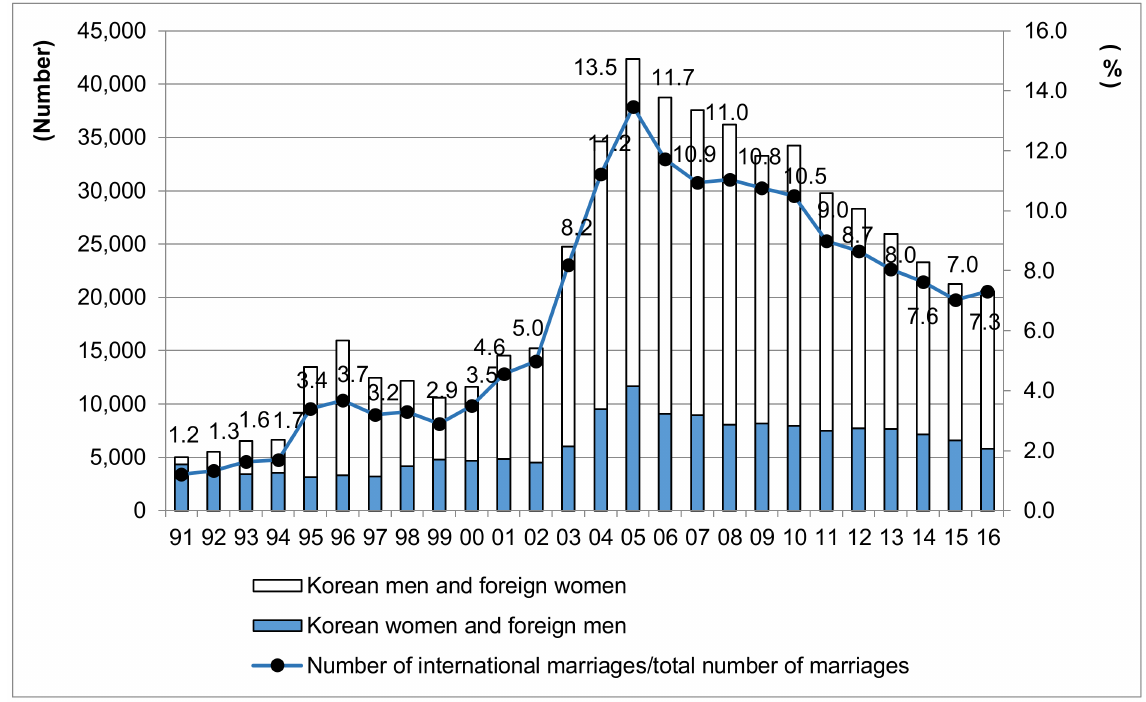
Figure 1. Trends in the number of multicultural families residing in Korea